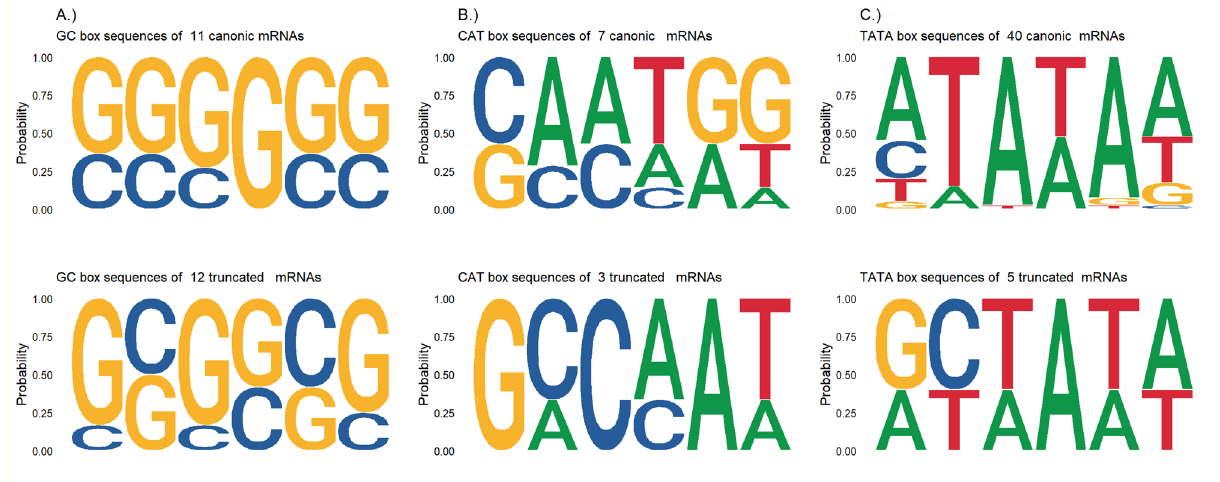
Figure 5. Weblogo of promoter elements: GC-boxes ( A ), CAT-boxes ( B ) and TATA-boxes ( C ) of truncated and canonical transcripts. Only those host genes were selected for the comparison that contained embedded genes. The number of each transcript that was found to contain promoter elements are shown above the respective